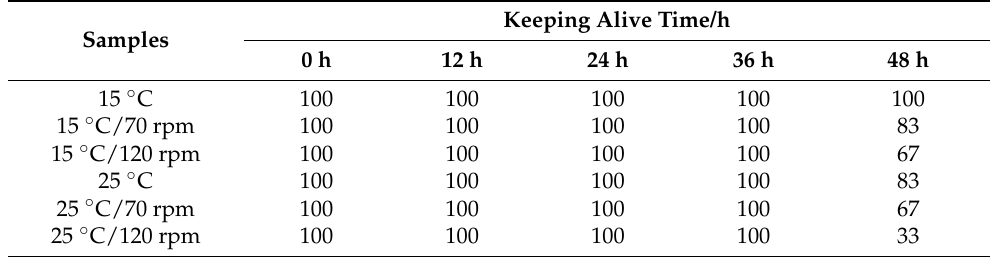
Table 2. Survival of pearl gentian groupers at different temperatures and vibration